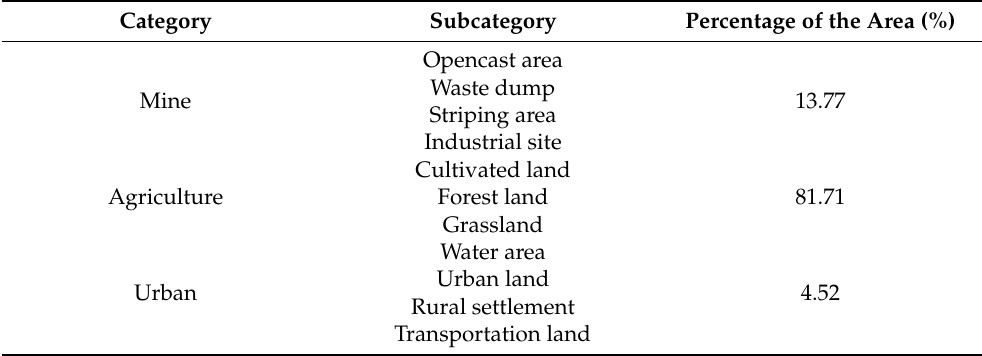
Table 1. Summary of land use in the mine–agriculture–urban compound area. (The data were extracted from Figure 7, and the table was made by Shufei